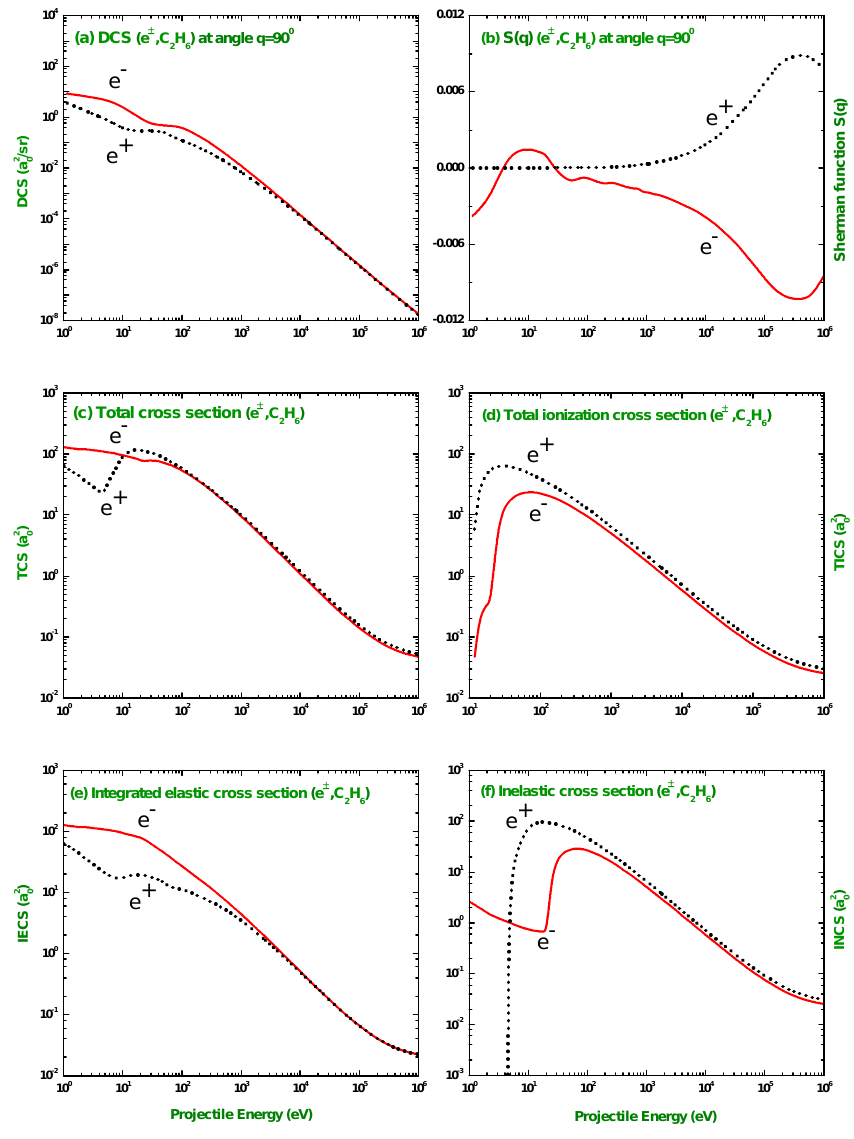
Figure 14. Comparison of ( a ) DCS ( a 2 / sr ) , ( b ) Sherman function, ( c ) TCS, ( d ) TICS, ( e ) IECS, and 0 ) for the scattering of electrons and positrons from C ( f ) INCS ( a 2 2 H 6 . Theoretical: Sherman Function 0 (IAM) and DCS, TCS, TICS, IECS and INCS